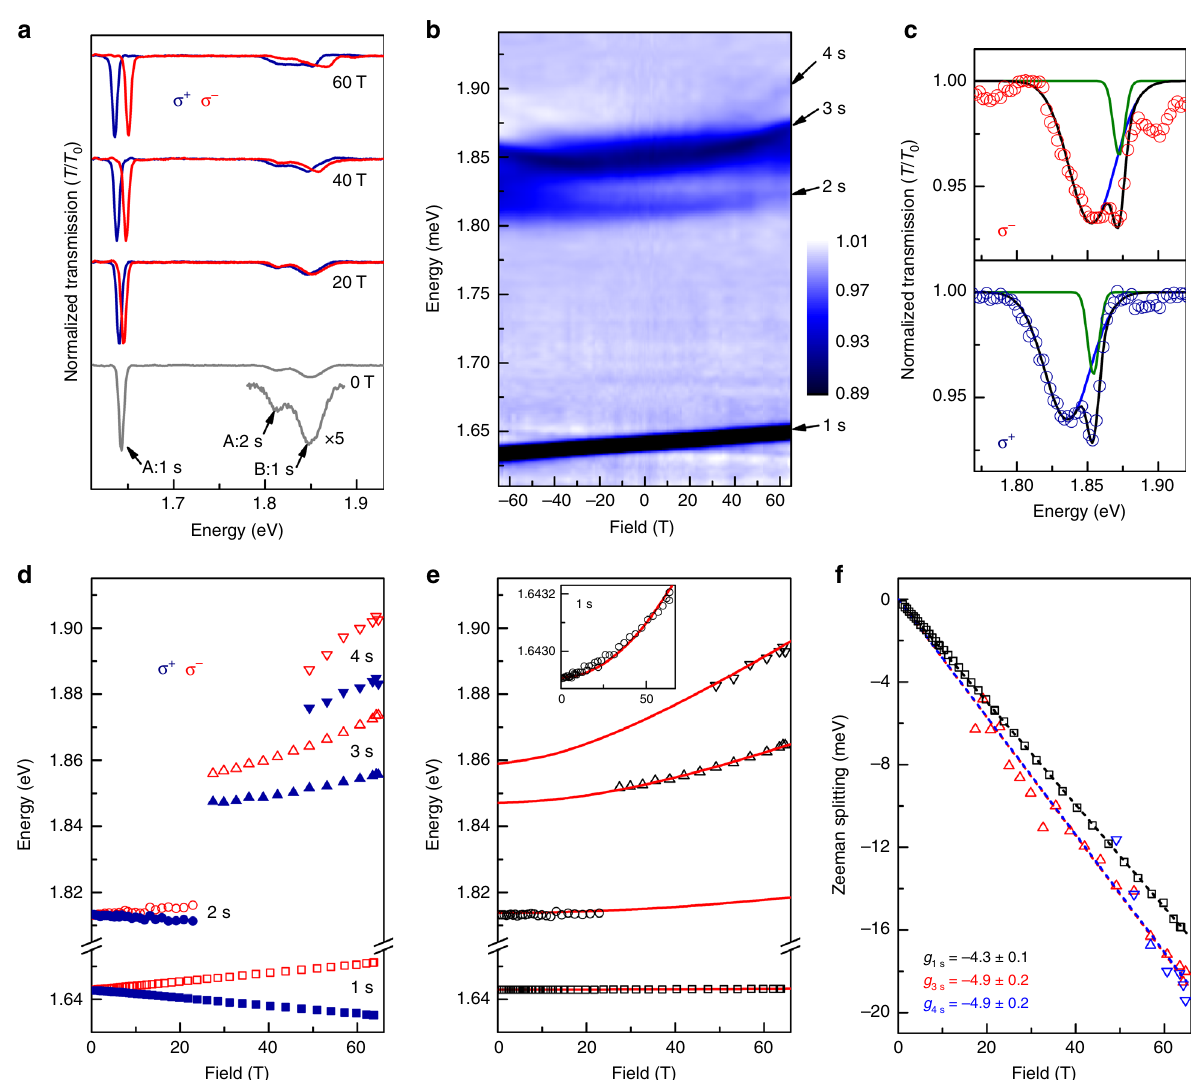
Fig. 4 Magneto-optical spectroscopy of monolayer MoSe 2 . a Normalized transmission spectra through an hBN-encapsulated MoSe 2 monolayer at selected magnetic fi elds, for both σ ± polarizations. The inset shows a 5 ´ magni fi ed spectrum of the higher energy features at 0 T. b Intensity map showing all the spectra from (cid:4) 65 to + 65 T. Excited ns Rydberg states of the neutral A exciton overlap with and emerge from the broader absorption at 1.85 eV that is due to the B exciton ground state. c Examples of two-Gaussian fi ts to the broad feature near 1.85 eV in σ (cid:4) (upper panel) and σ þ (lower panel) polarization at 65 T. In each panel, the two overlapping absorption peaks correspond to the B:1 s exciton (wide blue curve) and the A:3 s exciton (narrow green curve). The A:4 s state is also visible at (cid:3) 1.9 eV. d Measured exciton energies for both σ ± polarizations. e The average energies of the σ ± transitions. Red lines show ¼ 0 : 35 m r ¼ 3 : 9 nm , κ ¼ 4 : 4, and E ¼ 1 : 874 eV. The states that emerge at high magnetic the modeled exciton energies (see text). Parameters: m 0 , 0 r gap fi elds from the B:1 s exciton absorption correspond very well to the A:3 s and A:4 s Rydberg states. Inset: Expanded plot of the 1 s exciton energy, showing its very small quadratic diamagnetic shift. f The Zeeman splitting of the A:1 s , A:3 s , and A:4 s exciton states; dashed lines show linear fi